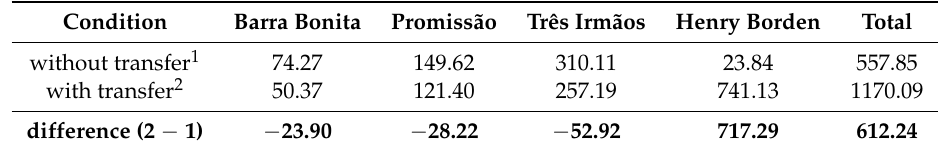
Figure 11. Comparison of hydraulic generation with and without transfer for case study 02. Table 2. Comparison of hydroelectric generation average of the system with and without transference fo case study 02 (average